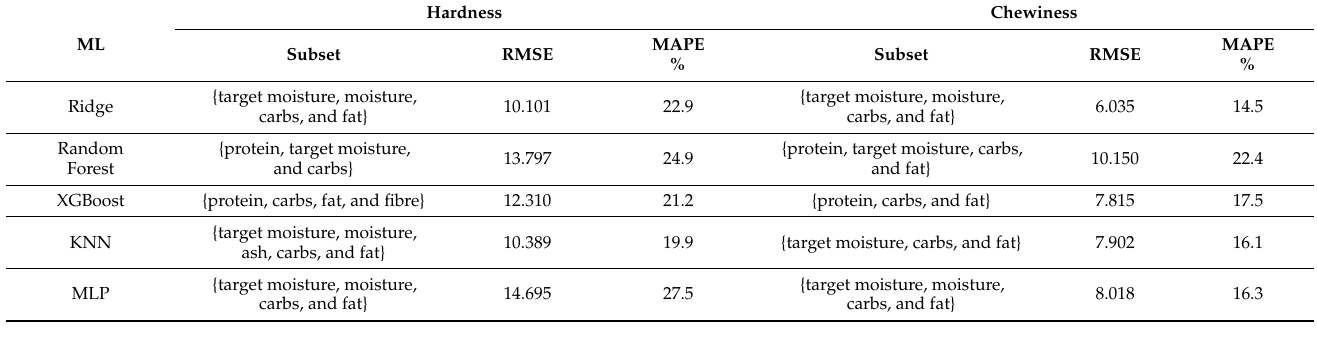
Table 2. Prediction Performances for the Textural Properties.